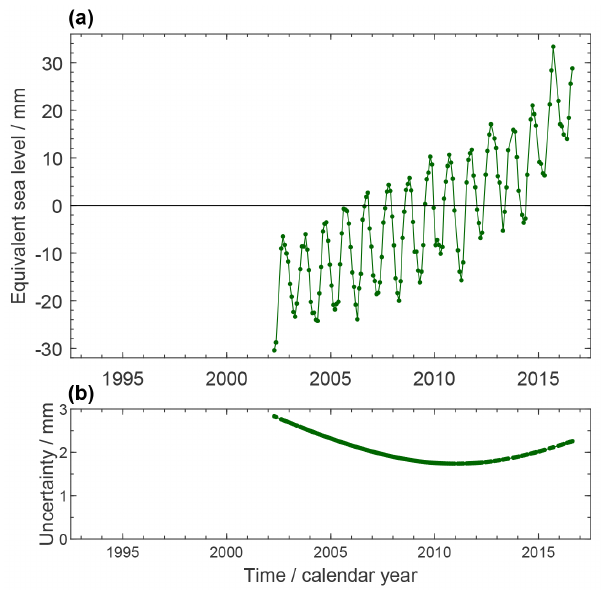
Figure 4. (a) Ocean-mass component of GMSL change, derived from the ITSG-Grace2018 spherical harmonic GRACE monthly solutions with a GIA correction according to Caron et al. (2018). Mass change of the global ocean is expressed in terms of equivalent GMSL change with respect to the mean of the reference interval of 2006–2015. Time series are shown in their original temporal sam- pling where some months are missing. (b) Uncertainties assessed for the estimates in (a)